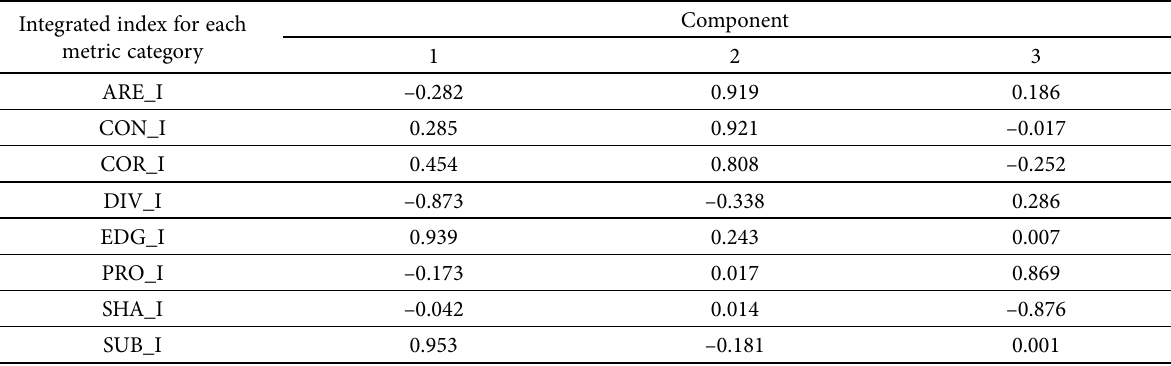
Table 4. Rotated component matrix and variance explained for UGS pattern and structure characteristics for 17 districts in Shanghai Integrated index for